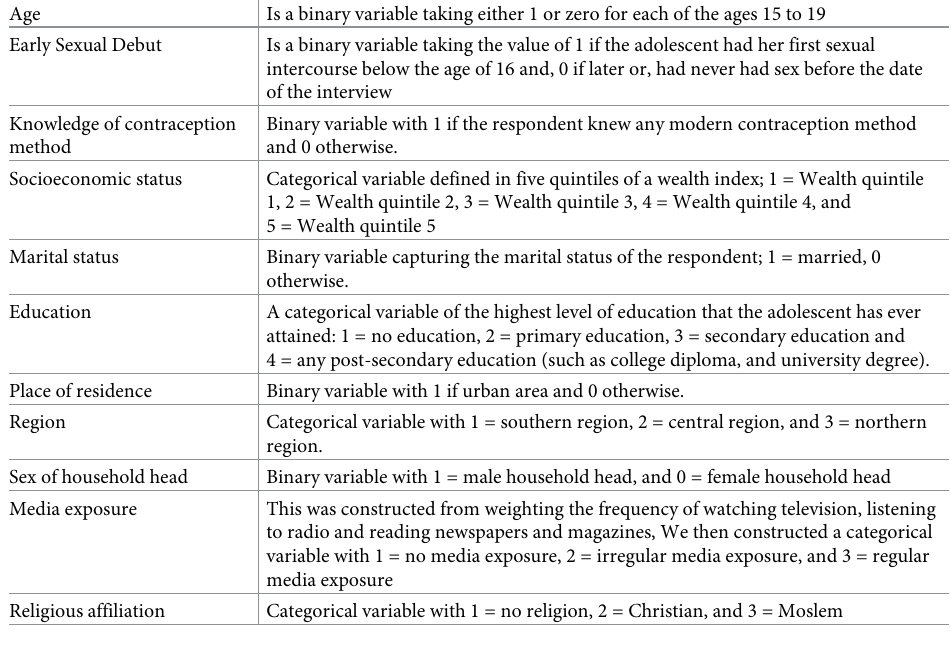
Table 1. Description of explanatory